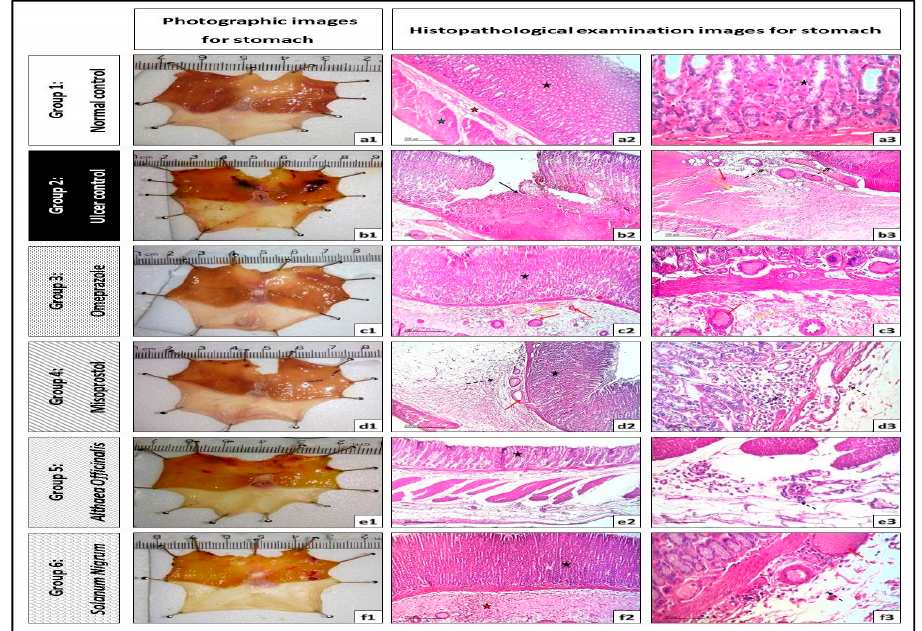
Figure 4. Photographic image from stomachs and histopathological examination image (50 µ m–200 µ m magnification) of each group. Where: ( a1 – a3 ): normal control group, ( b1 – b3 ): gastric ulcer control group (pyloric-ligation / indomethacin-induced gastric-ulceration), ( c1 – c3 ): omeprazole (20 mg / kg, p.o.) group, ( d1 – d3 ): misoprostol (300 µ g / kg, p.o.) group, ( e1 – e3 ): Althaea o ffi cinalis (100 mg / kg, p.o.) group, ( f1 – f3 ): Solanum nigrum (200 mg / kg, p.o.) group. Where: (black star) is gastric mucosa and